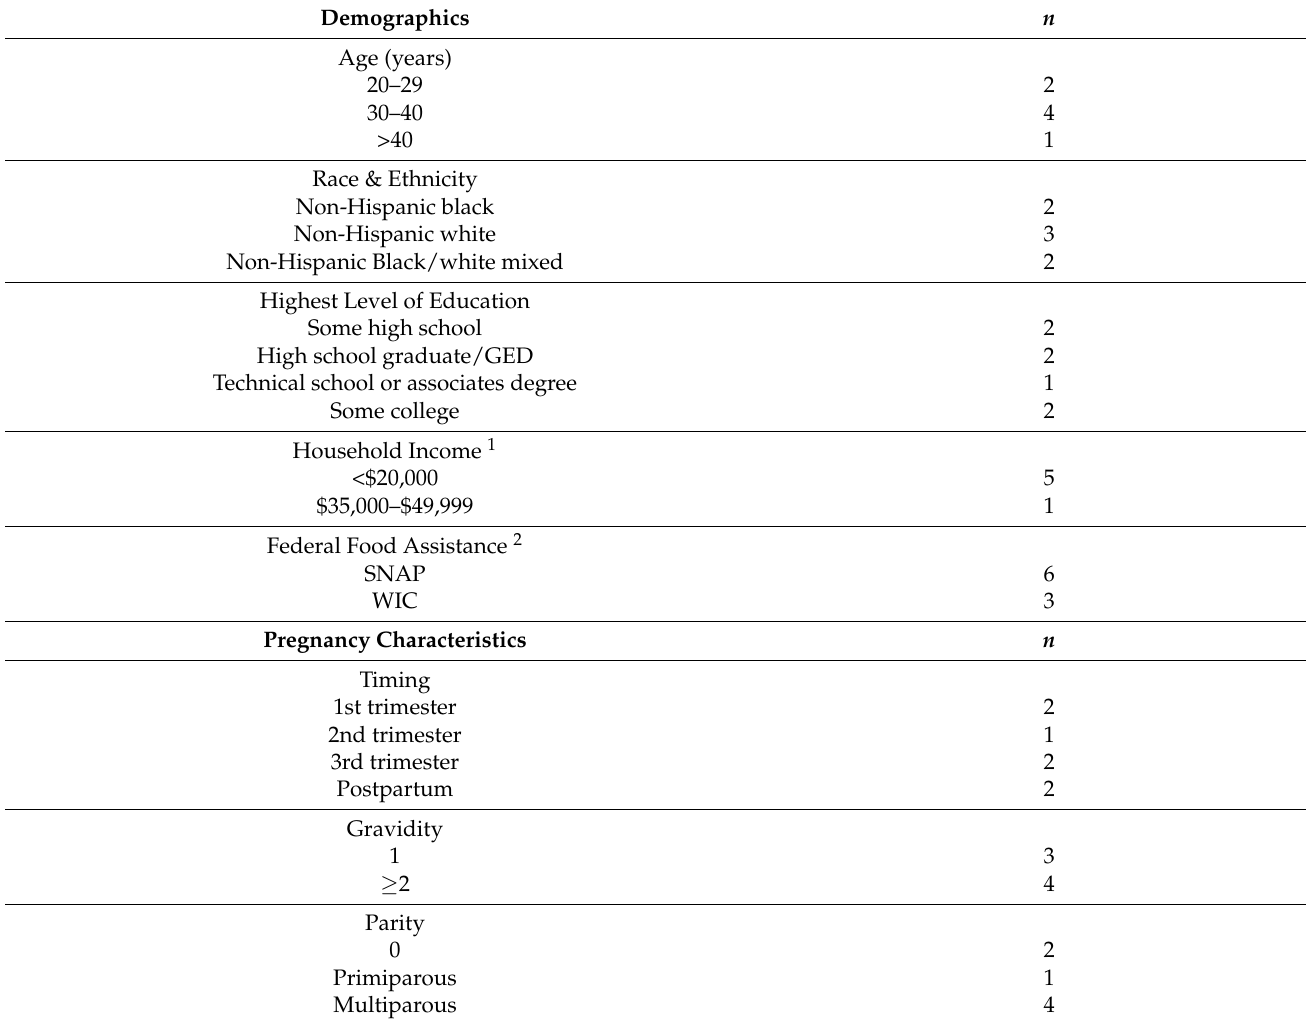
Table 1. Demographics and characteristics of